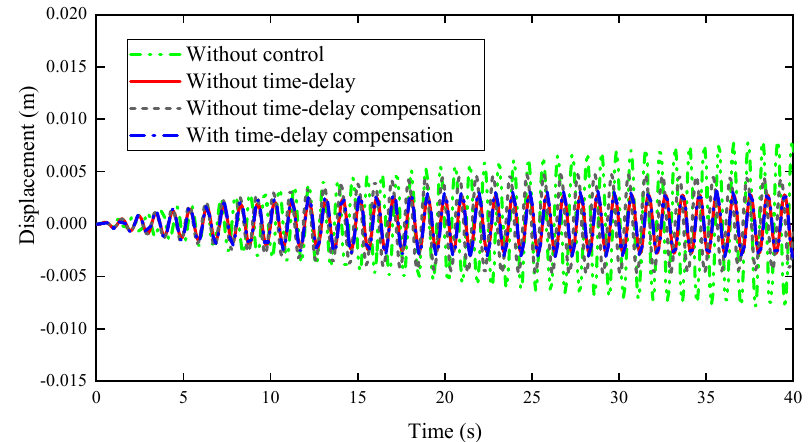
Figure 7. The time history of displacement at mid-span under harmonic excitation (0.11 s time-delay). Table 3. Response reduction at mid-span of three control strategies under harmonic excitation.